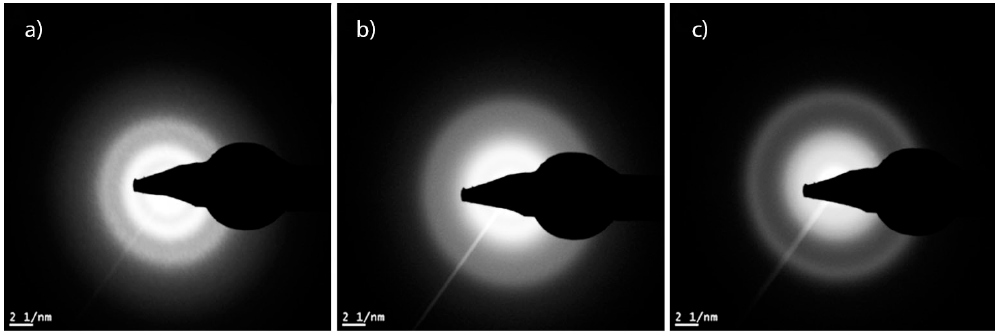
Figure 3. Diffraction patterns from process 1 ( a ); process 2 ( b ) and process 3 ( c ).